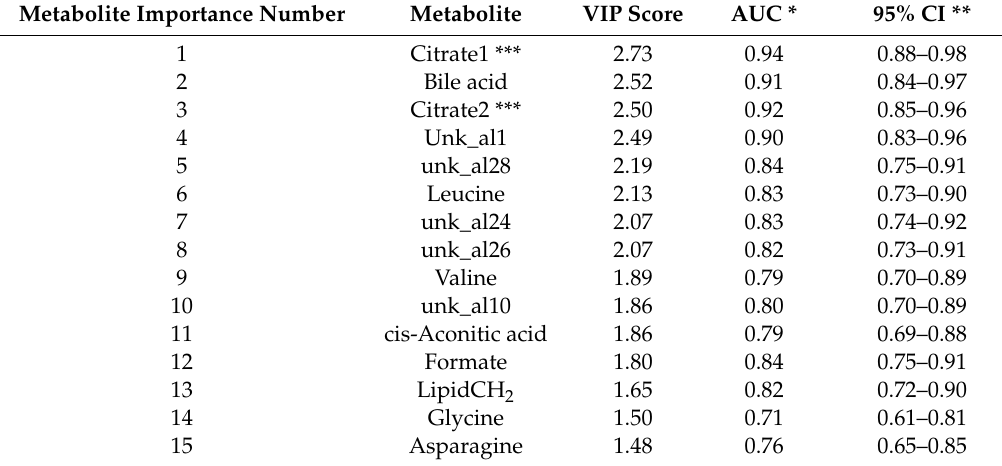
Table 3. Top 15 metabolites according to PLS-DA of AKI compared to the combined control group (non-AKI patients plus healthy control subjects), neonatal spectra excluded. AKI, acute kidney injury; PLS-DA, partial least squares discriminant analysis.